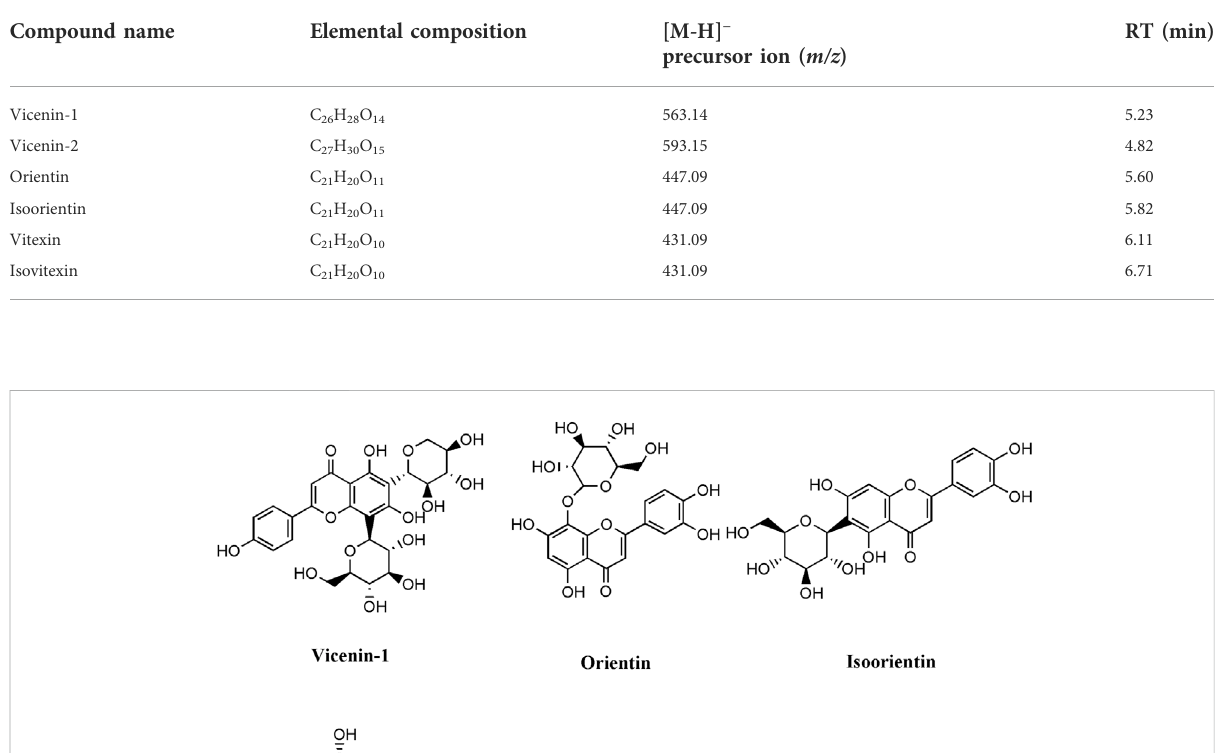
TABLE 3 Compounds identi fi ed from O. Syriacum ethanolic crude